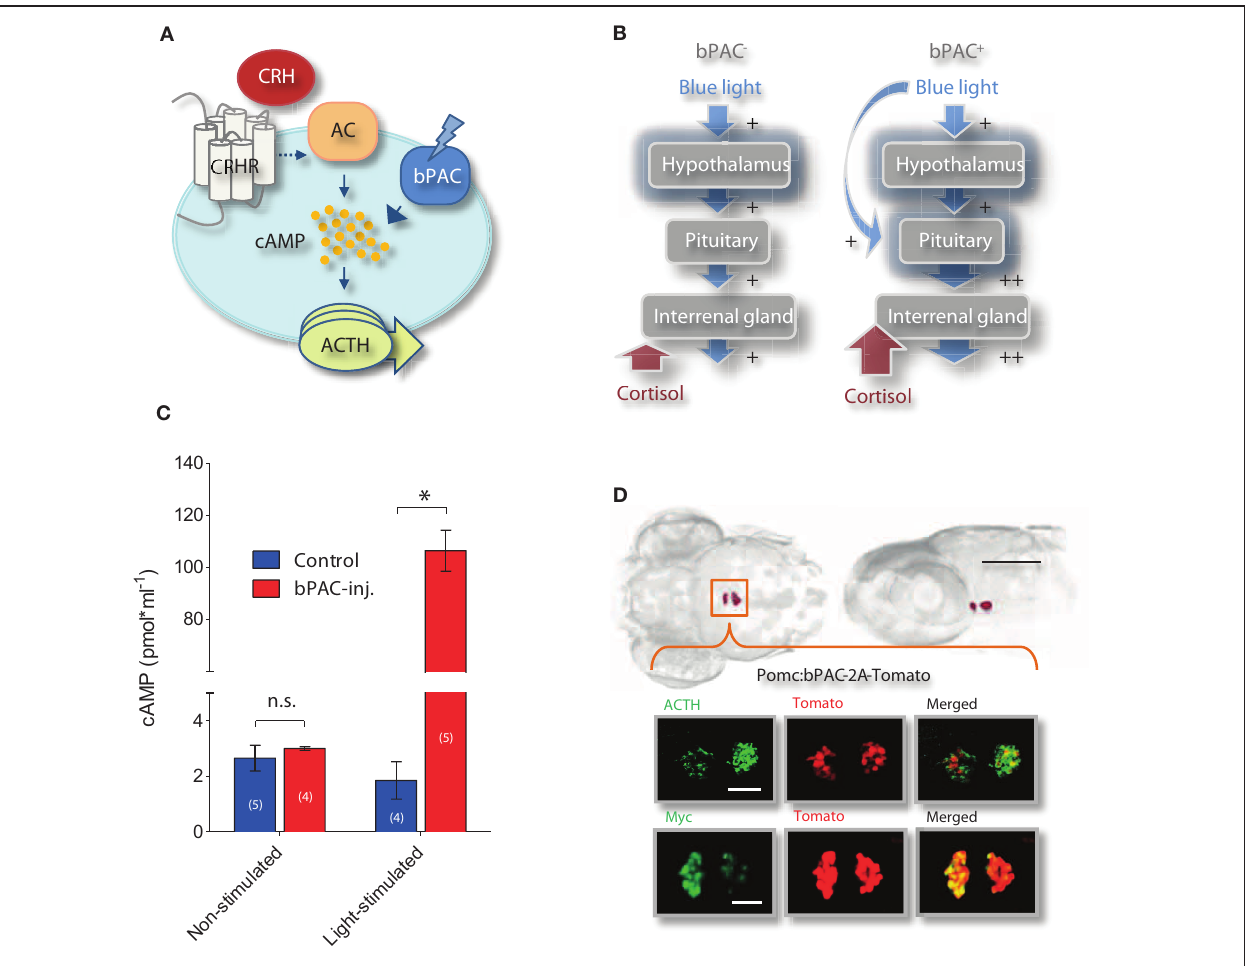
FIGURE 2 | Optogenetic increase of the gain of the stress axis. (A) In pituitary corticotrophs, Beggiatoa photoactivated adenylyl cyclase (bPAC) is expected to amplify CRH signaling and ACTH release; CRHR, CRH receptor; AC, adenylyl cyclase. (B) We aimed to modify the gain of the HPI axis by targeting bPAC to pituitary corticotrophs. Based on this rationale, blue-light stimulation of bPAC is expected to enhance the increase in cAMP that is central to CRH signaling in corticotroph cells, thereby amplifying ACTH and subsequent cortisol release while preserving analogous levels of hypothalamus activation. According to this